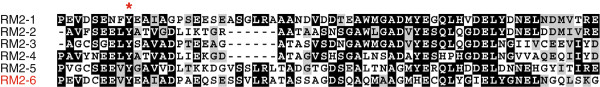
Alignment of the amino acid sequences of the six RM2 domains [10]. Sequences were aligned using the ClustalW program [15] and formatted with BOXSHADE (version 3.21, written by K. Hofmann and M. Baron). The conserved tyrosine residue is indicated by a red asterisk. The sixth RM2 domain, shown in red, was chosen for further analysis by bacterial expression.